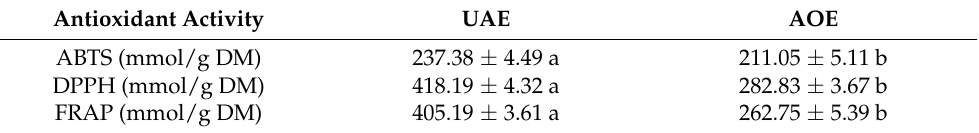
Table 6. Antioxidant capacity of Psidium cattleianum leaf extracts by optimal UAE conditions and conventional aqueous–organic extraction.